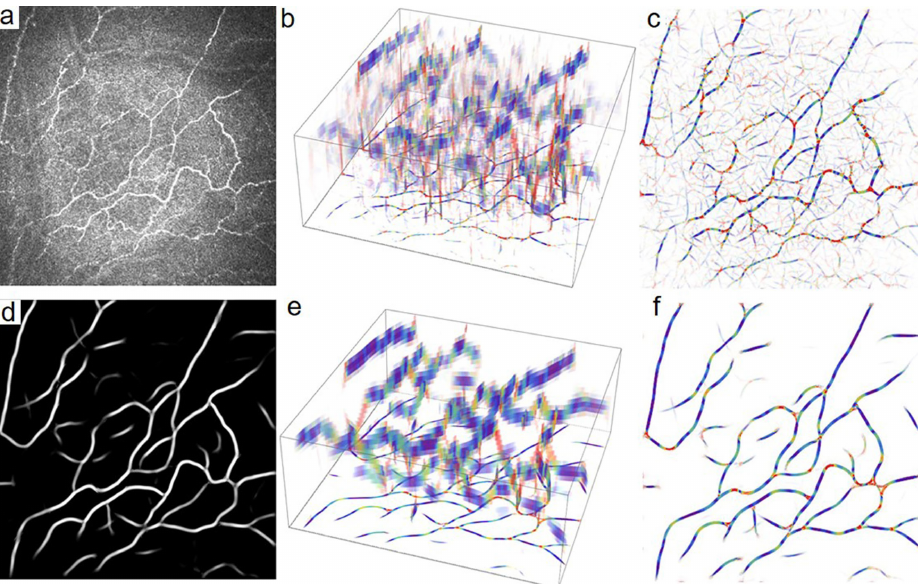
Figure 6. Comparison results of the exponential curvature estimation ( b , c ) and ( e , f ) from original image ( a ) and our enhanced image ( d